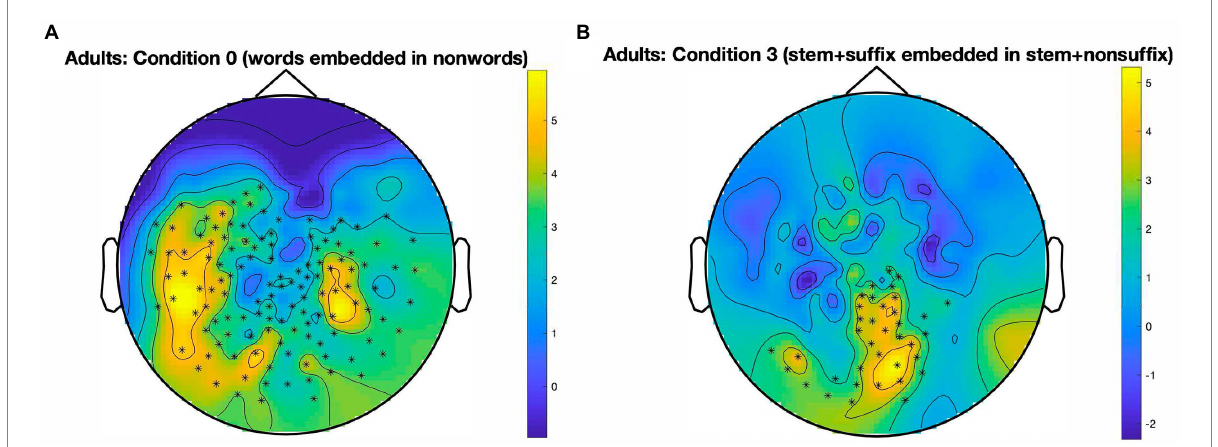
FIGURE 2 Sensor-level clusters in which a significant oddball response emerged, by condition. Data from skilled adult readers. (A) : Large temporo-parieto- occipital cluster (mostly left-lateralized, with a right-lateralized part) indicating widespread identification of words in nonwords, in Condition 0; p < 0.001, cluster alpha level = 0.05. (B) : Left and central occipital cluster for the identification of stem + suffix oddballs in stem + nonsuffix base stimuli, in Condition 3; p < 0.001, cluster alpha level = 0.05. Color bars represent SNR on a continuous scale (blue = low, yellow = high). Condition 0: words in nonwords (e.g., roll in kltq ); Condition 3: stem + suffix in stem + nonsuffix ( softity in terpert